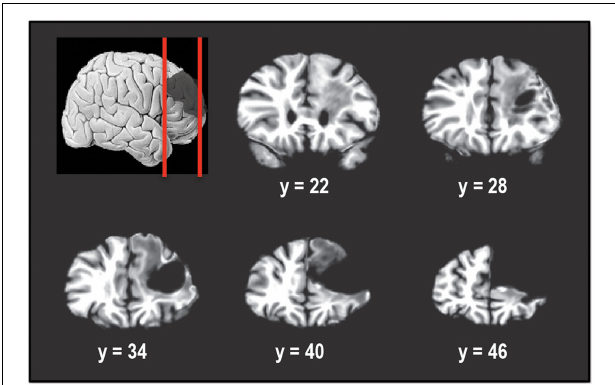
FIGURE 1 | Coronal slices taken 6mm apart starting posteriorly at y = 22 and showing the extent of the tumor resection in the right hemisphere. The resection encompassed right superior frontal gyrus and right middle frontal gyrus, including Brodmann areas 9, 46, and 10. Right inferior frontal gyrus was almost completely spared. In Talairach normalized space, the resection extended from x of 0 (midline) to about 50mm, y of 23 to y of 66mm (anterior tip of brain) and z of − 4 to z of 50mm (superior tip of